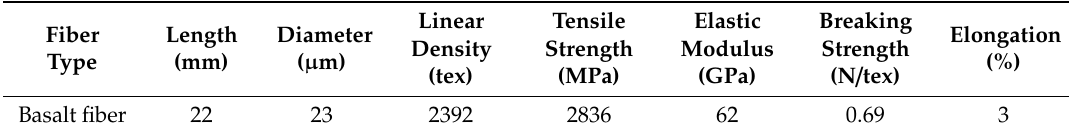
Table 2. Properties of basalt